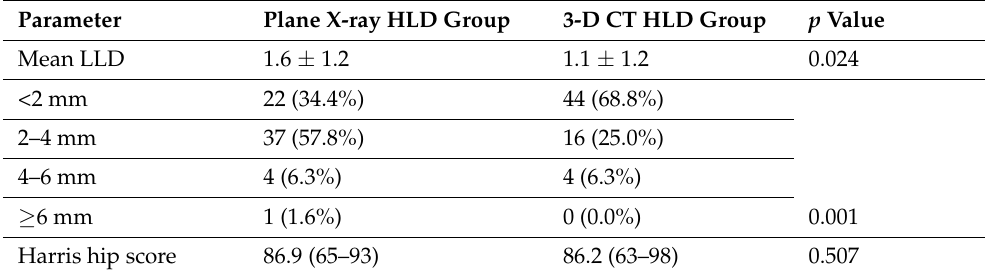
Table 2. Patients’ postoperative data.